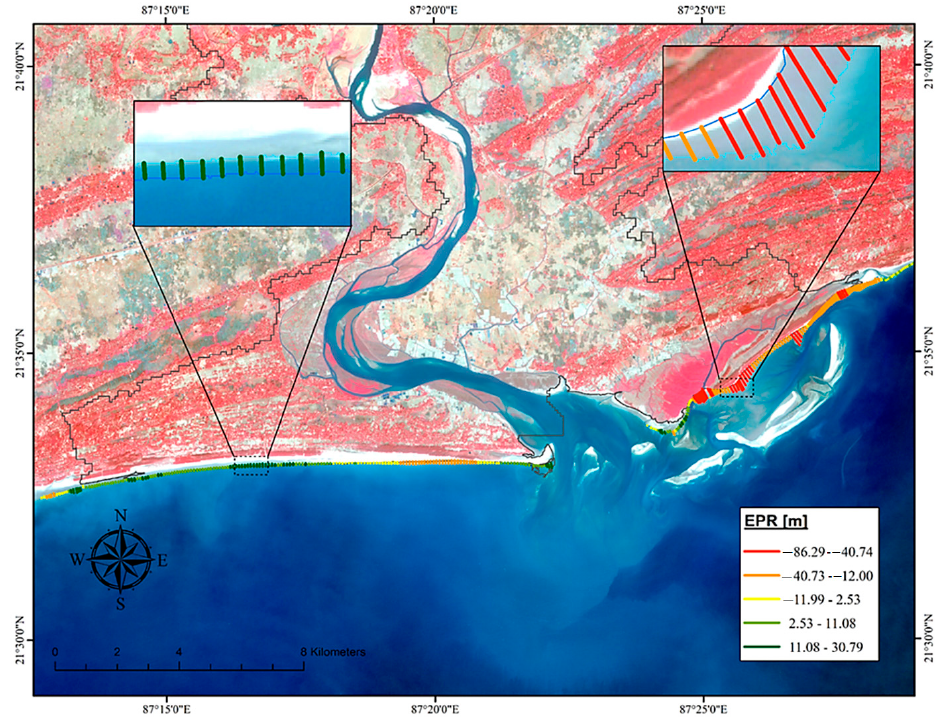
Figure 12. Transect-wise EPR on the Landsat 8 OLI/TIRS image of the Subarnarekha’s estuarine section (Digha Coast).